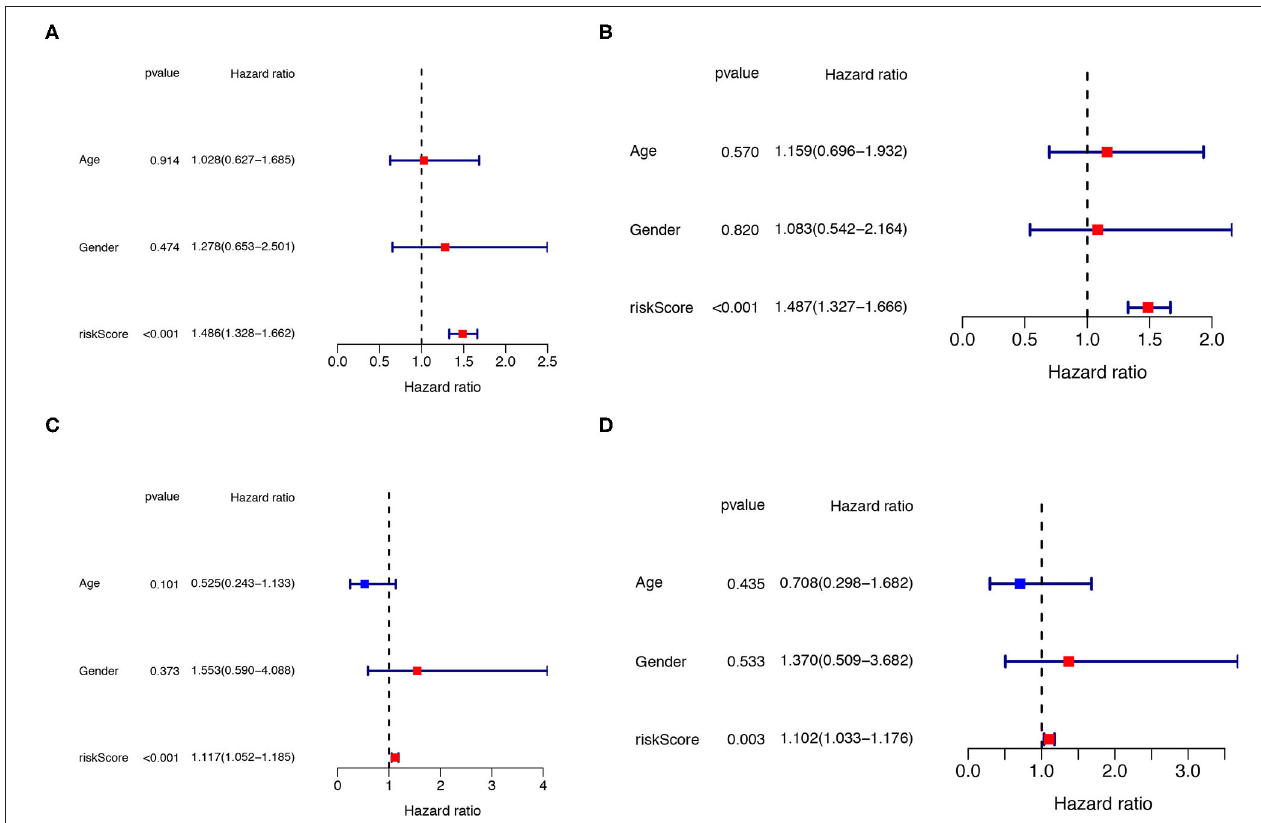
FIGURE 7 | Independent prognostic analysis of clinical parameters and risk score. The univariate (A) and multivariate (B) Cox regression analysis of the associations between the risk score, the clinical parameters and OS of IPF patients in the training cohort. The univariate (C) and multivariate (D) Cox regression analysis of the associations between the risk score, clinical parameters and OS of IPF patients in the testing cohort. IPF, idiopathic pulmonary fibrosis; OS, overall